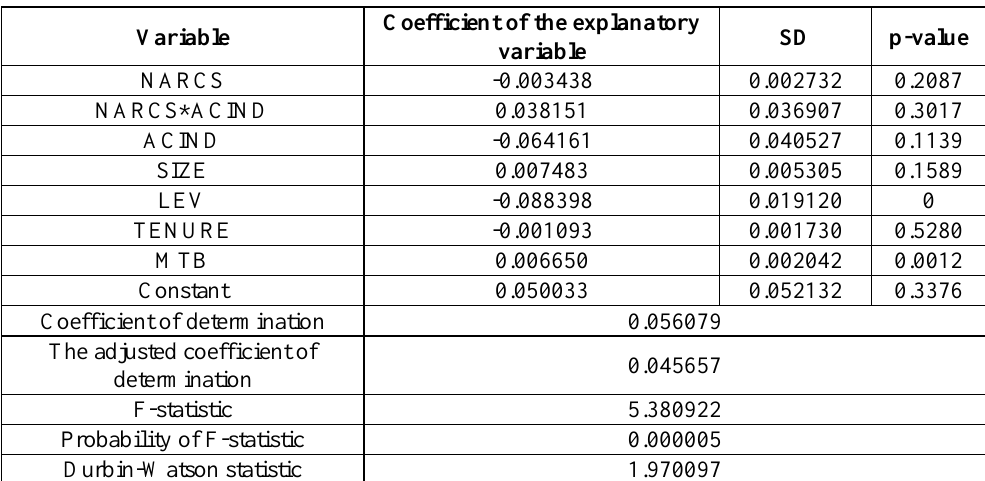
Table 9. Model fit for